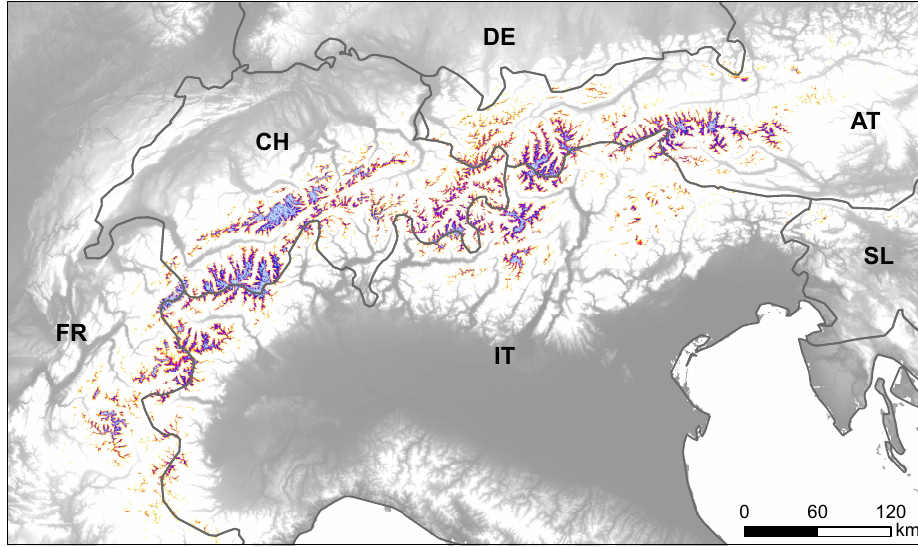
Fig. 4. Alpine Permafrost Index Map (APIM) shown for the European Alps (AT: Austria, CH: Switzerland, DE: Germany, FR: France, IT: Italy, SL: Slovenia). The map should be interpreted together with the legend and interpretation key (Fig.